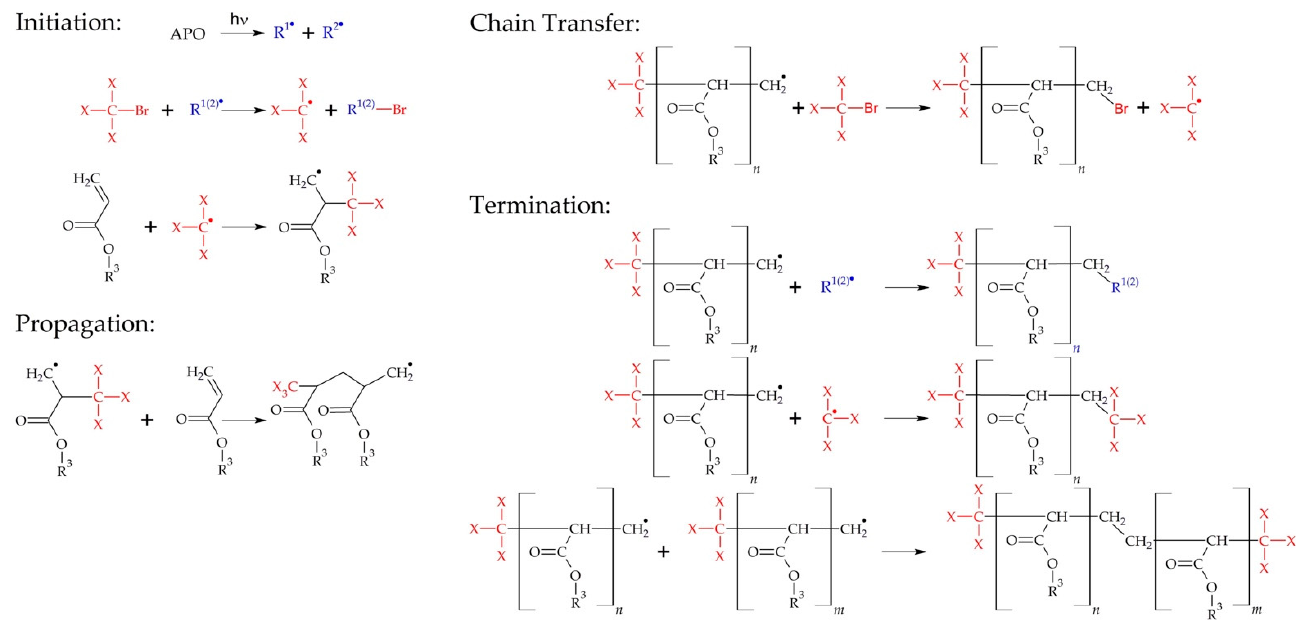
Figure 2. Scheme of the photochemically induced telomerization process where: R 1(2) is a radical formed from the decomposition of APO photoinitiator, X is a Br or Cl atom, R 3 is H, C 3 H 9 or C 6 H 6 COC 6 H 6 .